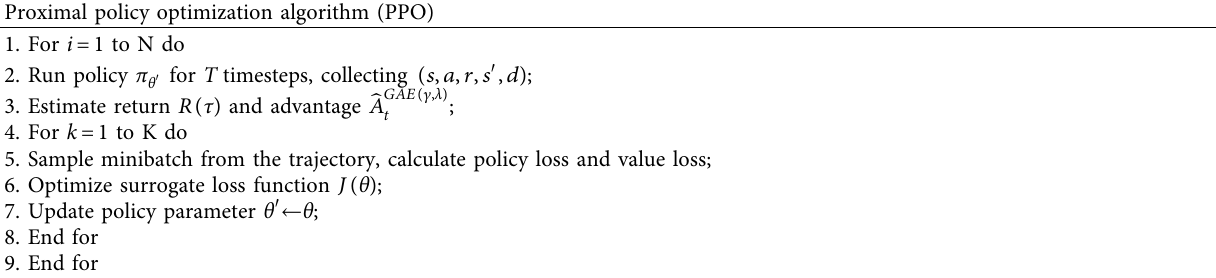
Table 2: Algorithm: PPO (CLIP).